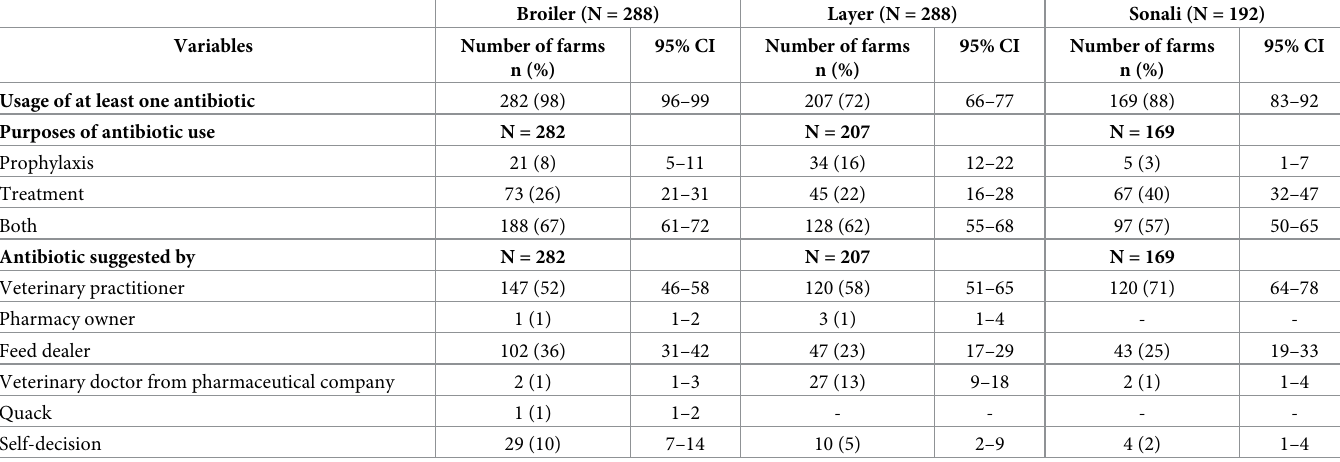
Table 5. Farm-level antibiotics used within the 14 days preceding visits to commercial broiler, layer and Sonali chicken farms in Bangladesh, during January-May